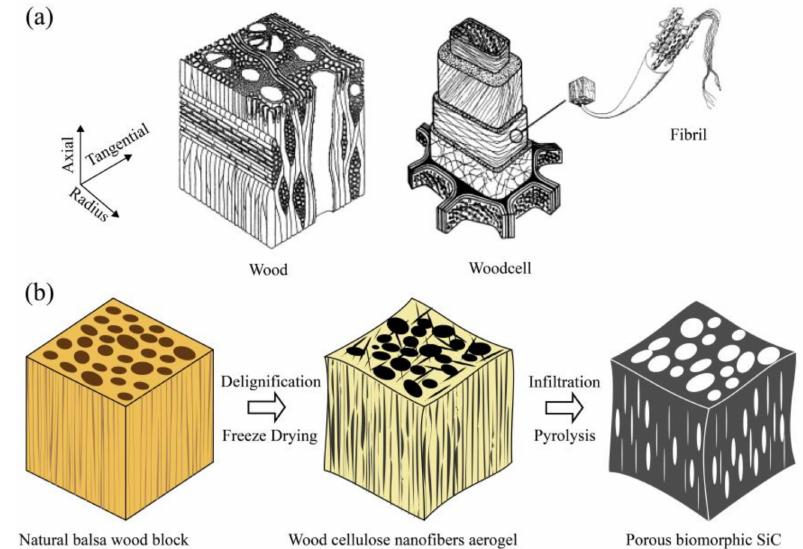
Figure 1. ( a ) Hierarchical microstructure of wood (reproduced with permission from Ref [1]) ( b ) illustration for the preparation of the biomorphic Silicon Carbide